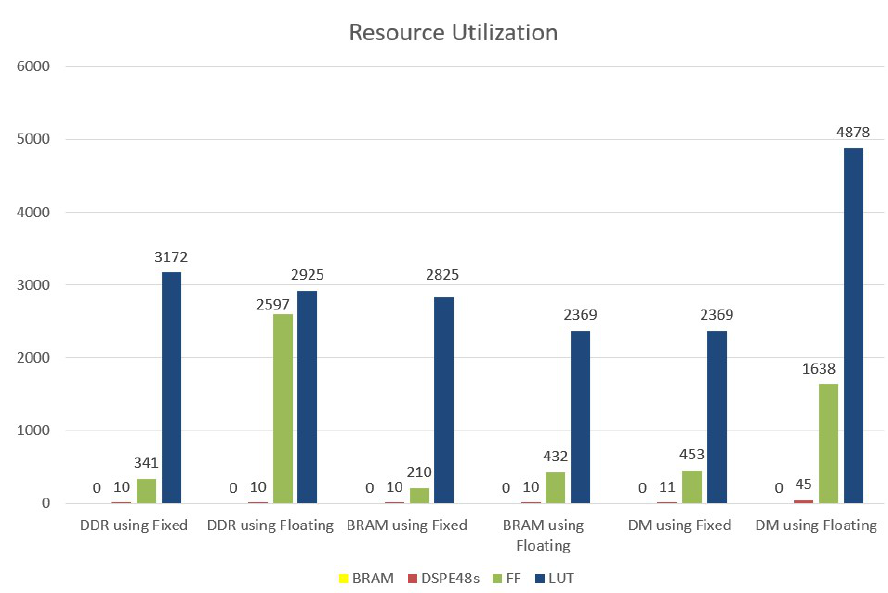
Figure 11. IP utilization for different memory